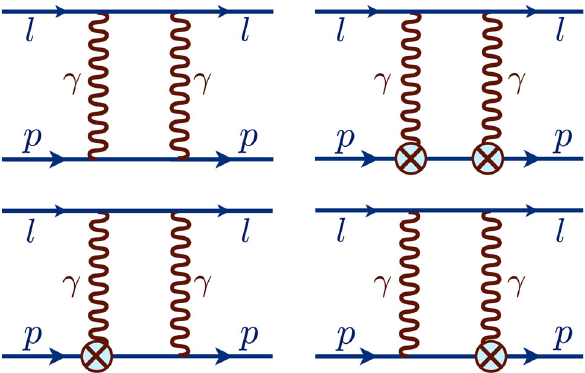
Fig. 8 Different contributions to the proton box diagram, depending on the different virtual photon–proton–proton vertices. The vertex with (without)thecrossdenotesthecontributionproportional tothe F P ( F D ) FF. The different diagrams show the F D F D (upper left panel), F P F P (upper right panel) and F D F P (lower panels) vertex